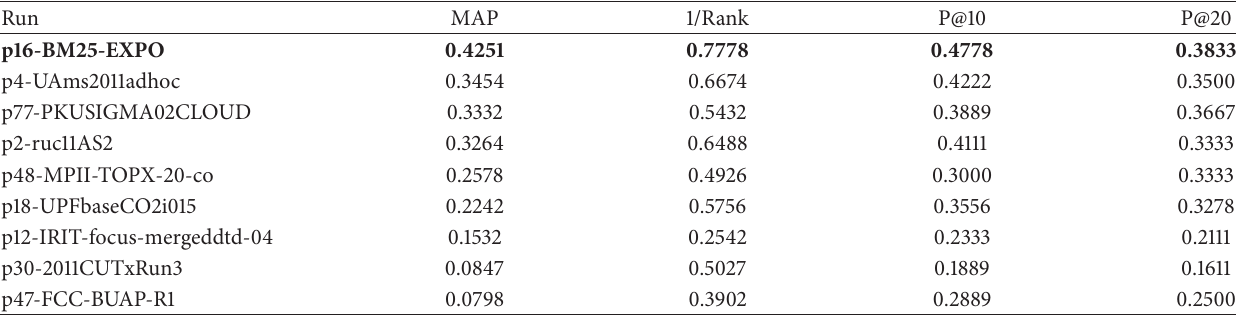
Table 9: Best performing runs based on MAP over the list